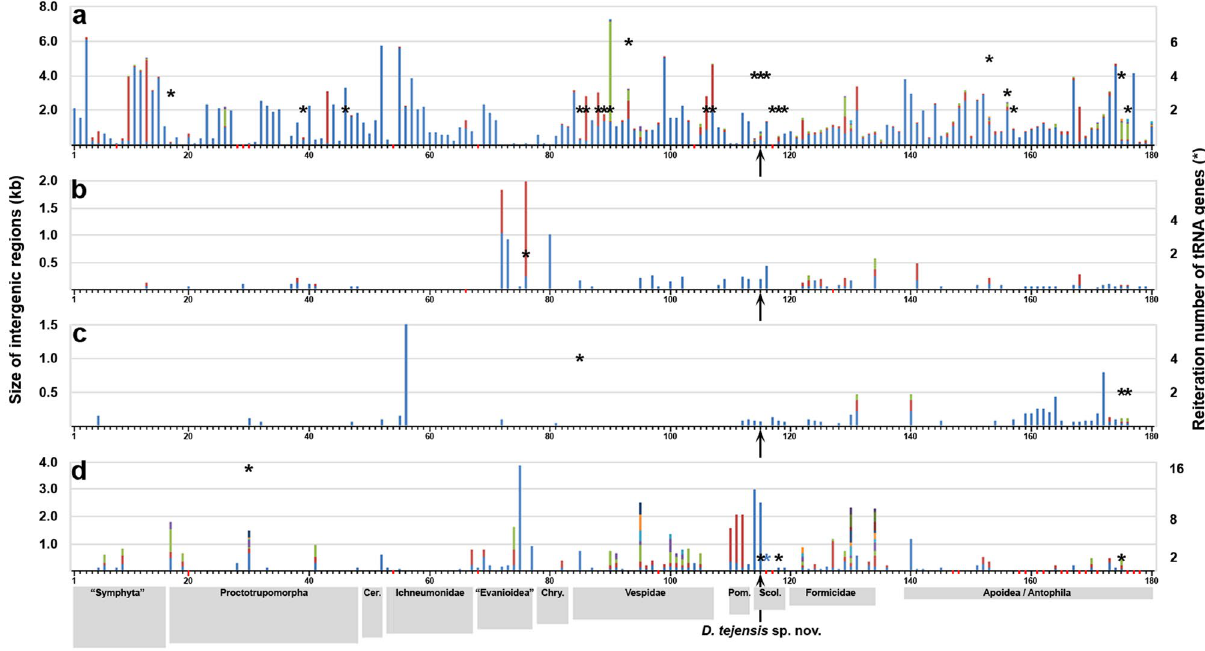
Figure 6. Increased intergenic distance and trn copy number in the mitogenomes of Hymenoptera. The 180 species analysed here are listed in Supplementary Table S4 together with additional details on the plotted data. Red marks on the x-axis indicate no data from a given mtDNA region. The graph bars represent noncoding regions larger than 50 bp. Different bar colours depict subregions of larger regions interrupted by trn genes/ pseudogenes. Abbreviations: Cer., Ceraphronoidea; Chry., Chrysidoidea s. lato ; Pom., Pompiloidea; Sco., Scoliidae. The following mitogenomic regions were analysed: ( a ) rrnS-nad2 or adjacent to at least one of these genes (including the CR); ( b ) nad2 - cox1 ; ( c ) cox1 - cox2 ; ( d ) nad3 - nad5 and/or other intervals. Asterisks denote the copy numbers of the following tRNA genes characterized by high covariance score and/or homology to